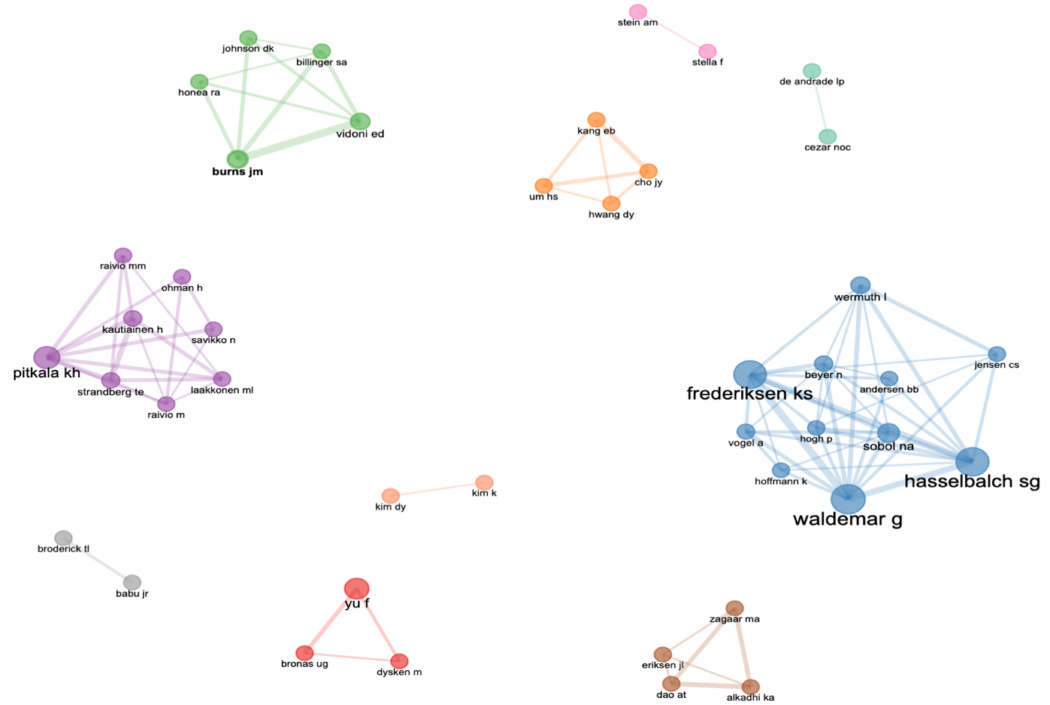
Figure 8. The authors’ collaboration network. (Affiliation—Blue: Denmark; Purple: Finland; Red, Green, Khaki, Gray: USA; Pink, Light Green: Brazil; Orange and Light Orange: